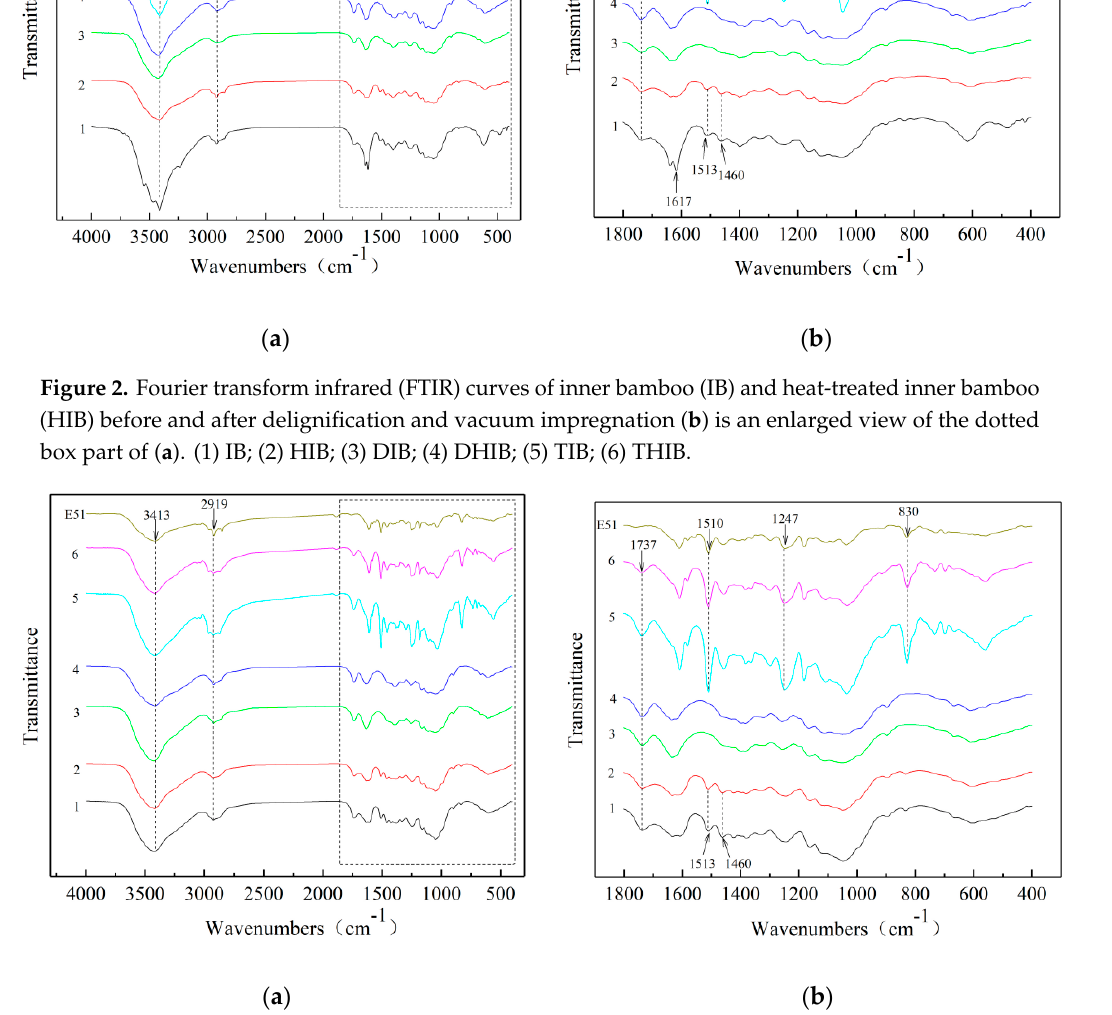
Figure 3. FTIR curves of outer bamboo (OB) and heat-treated outer bamboo (HOB) before and after delignification and vacuum impregnation (( b ) is an enlarged view of the dotted box part of ( a ). (1) OB; (2) HOB; (3) delignified outer bamboo (DOB); (4) delignified heat-treated outer bamboo (DHOB); (5) transparent outer bamboo (TOB); (6) transparent heat-treated outer bamboo (THOB)).